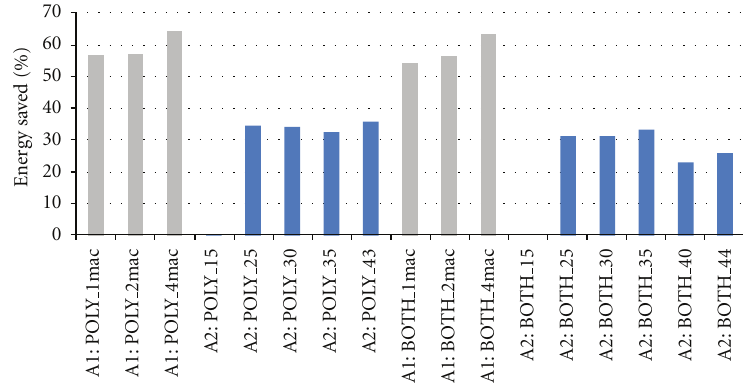
Figure 19: 64-bit PI: energy savings in percent for A1 versus A2, normalized to worst case.